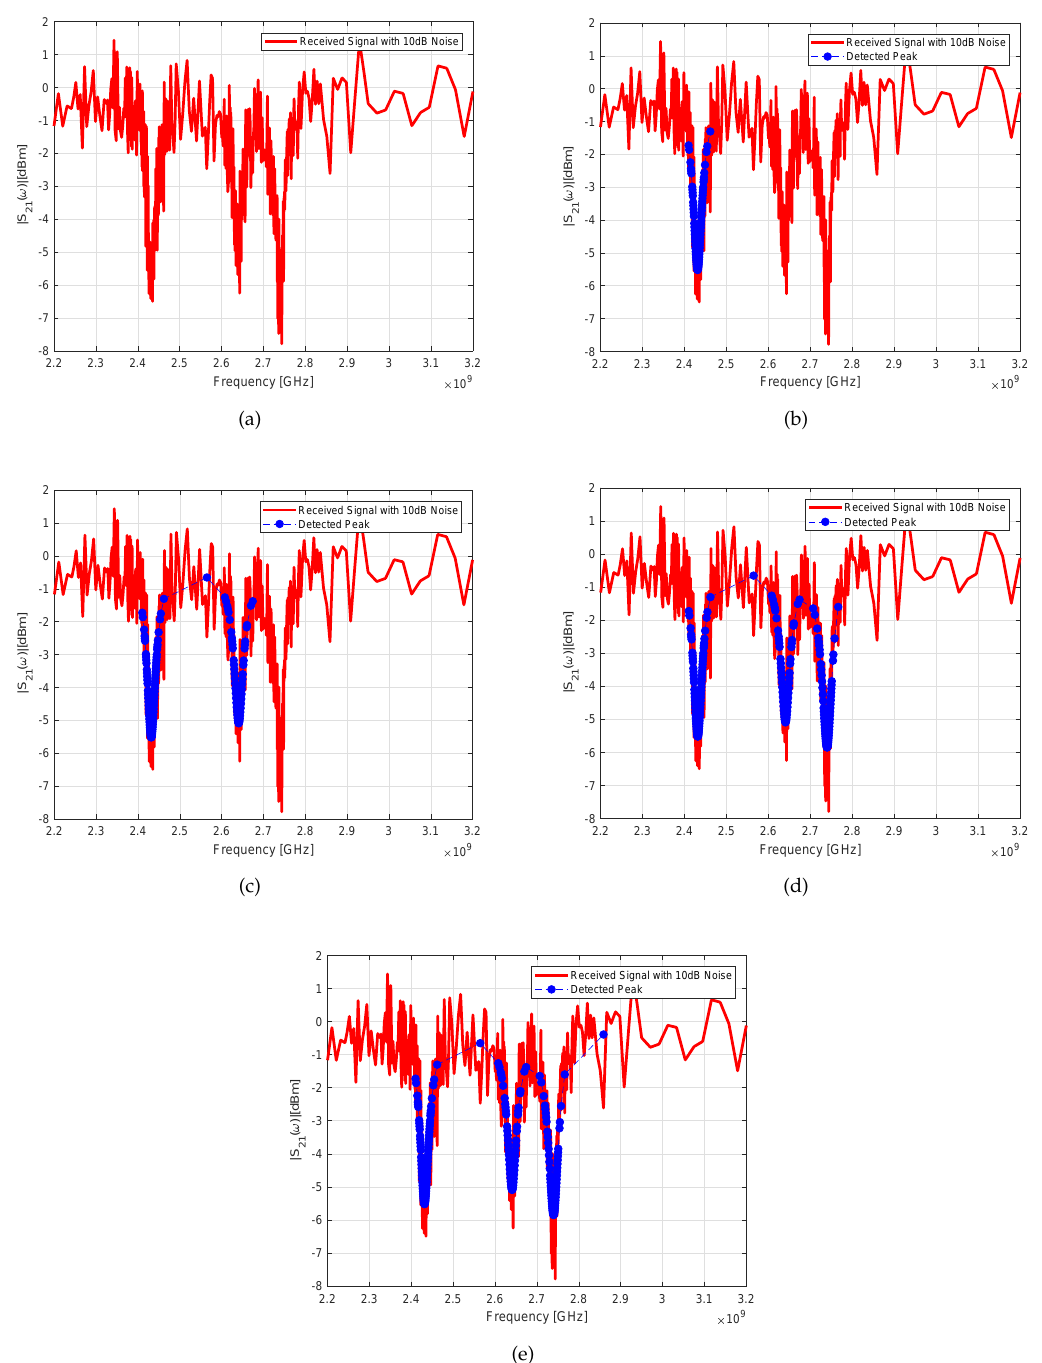
Figure 8. Numerical assessment, noisy scenario. Peaks detected for the tag configuration of 10110, ( a ) original detected signal, peaks between the frequency range of ( b ) 2.6–2.7 GHz, ( c ) 3.0–3.1 GHz, ( d ) 3.1–3.2 GHz with frequency shift at 3.1–3.2 GHz, and ( e ) final